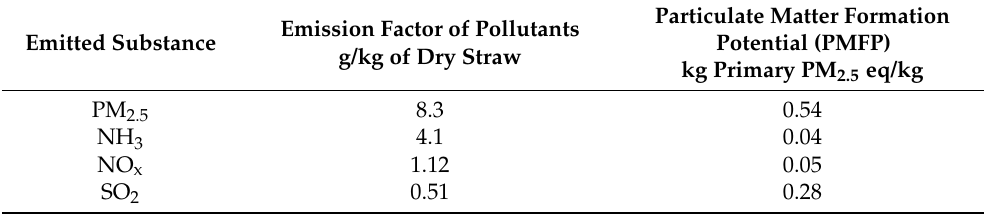
Table 1. Emission factors of pollutants from straw residue burning and particulate matter forma- tion potential.